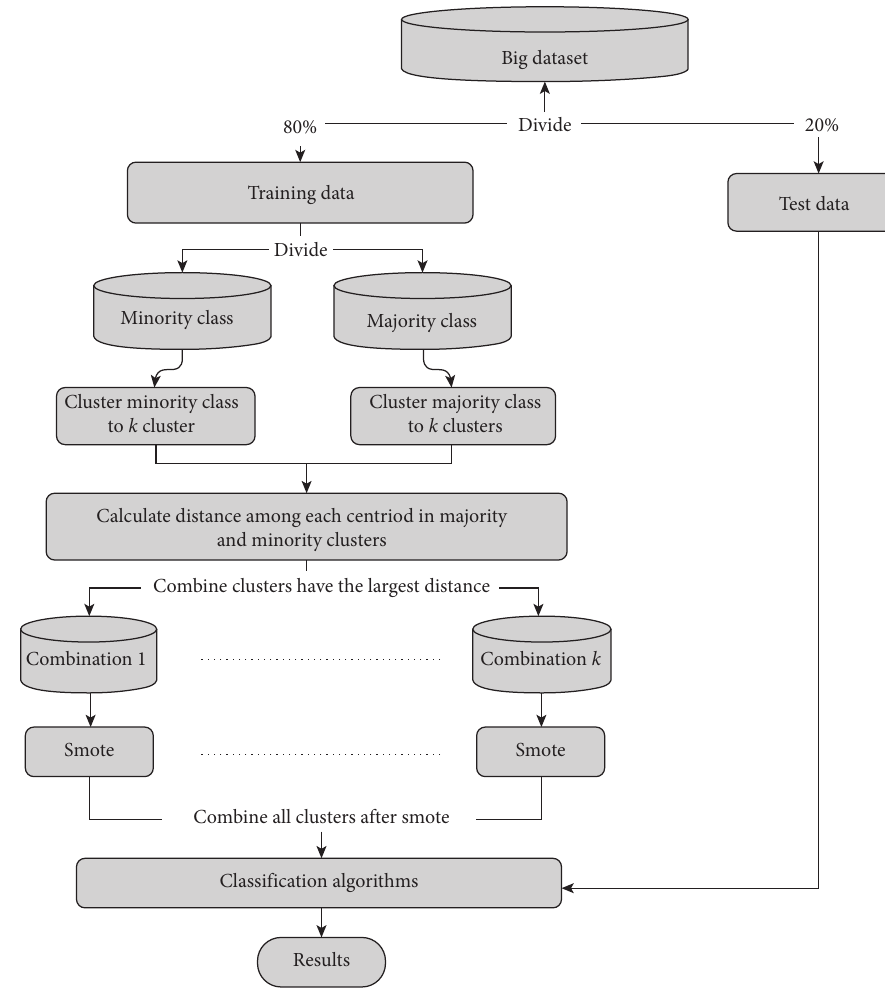
Figure 2: The proposed model.